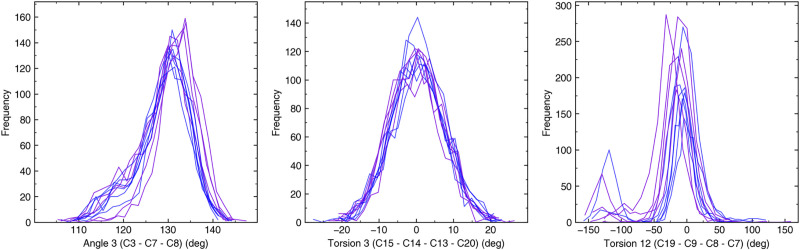
Frequency distribution of Angle 3, Torsion 3 and Torsion 12 observed in each opsin simulation.Blue and violet colors correspond to Sws2 photopigments with λmax values >430 nm vs. λmax values <430 nm, respectively.